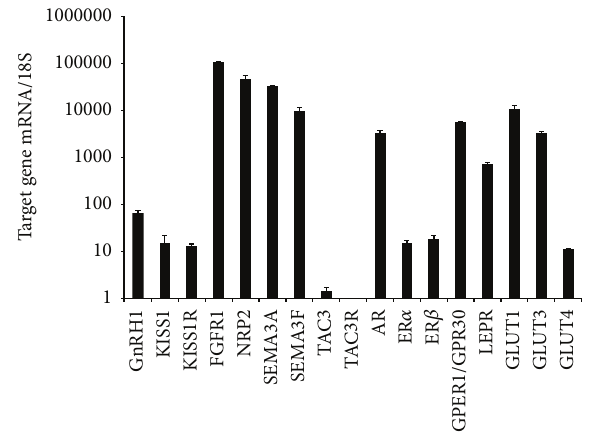
Figure 1: Gene expression profiling in FNC-B4 cells. Relative mRNA expression of genes relevant for GnRH neuron function was evaluated using quantitative RT-PCR. Data were calculated accord- ing to the comparative Ct method, using 18S rRNA subunit as the reference gene for normalization. Measurements were performed in four different cell preparations at different passages (from 5 to 10). were pooled and reported as the mean ±